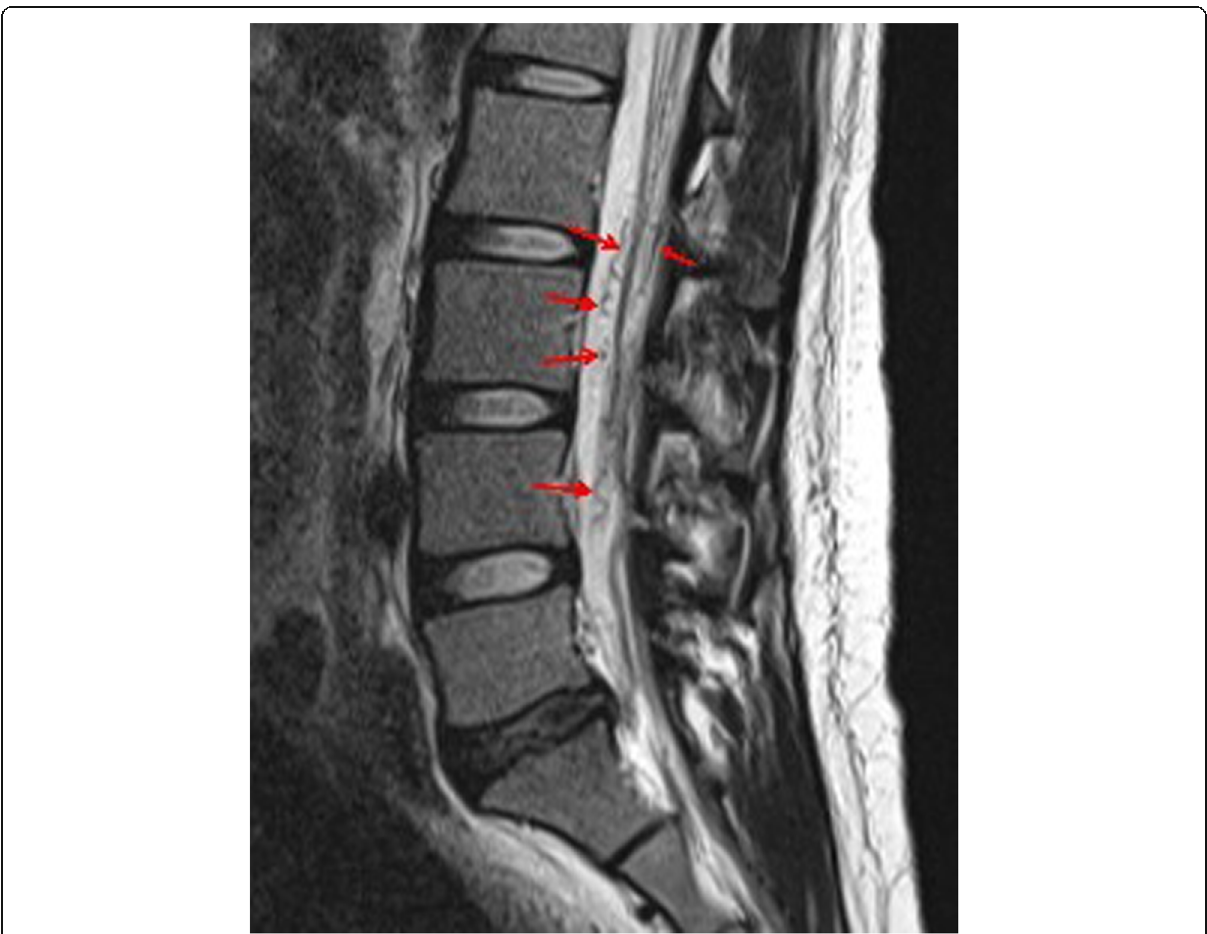
Fig. 3 Magnetic resonance imaging (T2-weighted image) in the lumbar level at 32 weeks of gestation. Flow voids (the arrows) suggest dilated draining